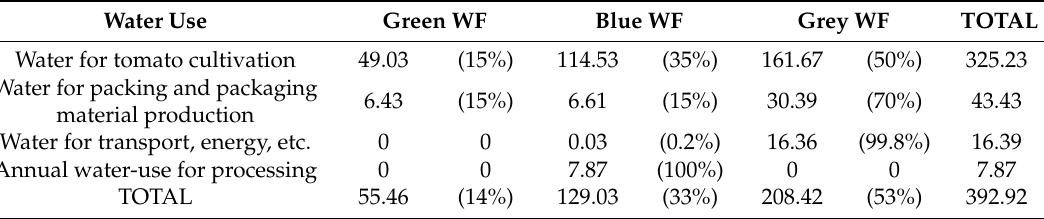
Table 3. The water footprint of Mutti processed tomato (m 3